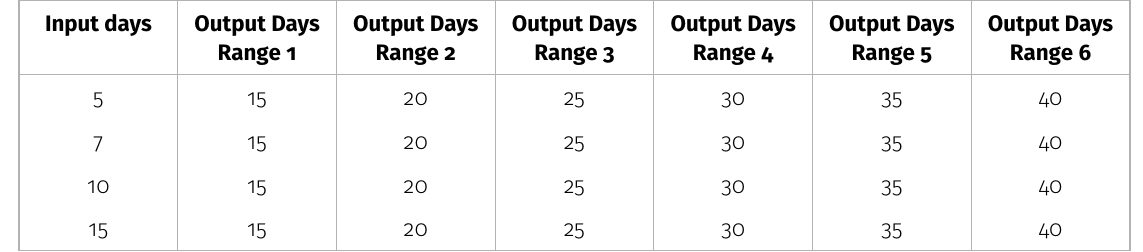
Table II. Input and output parameters for LSTM